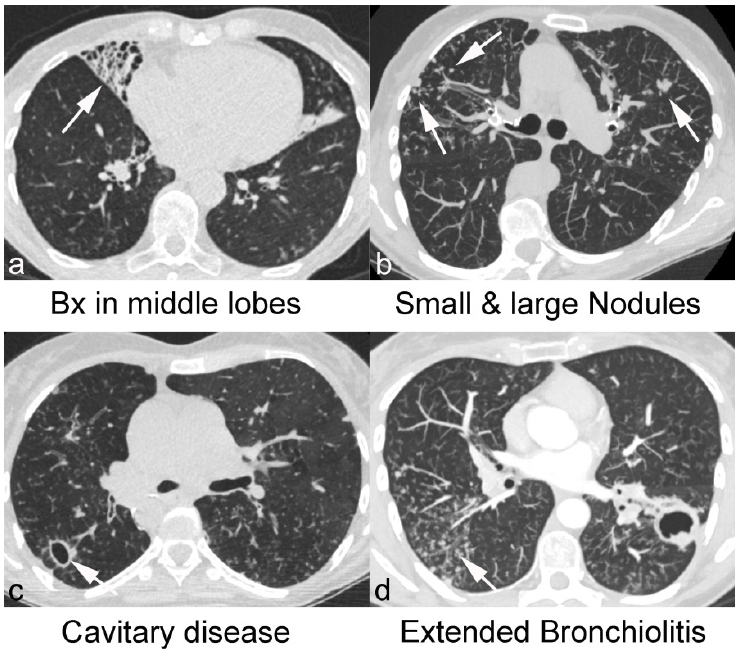
Figure 1. CT findings in patients with NTM-PD.